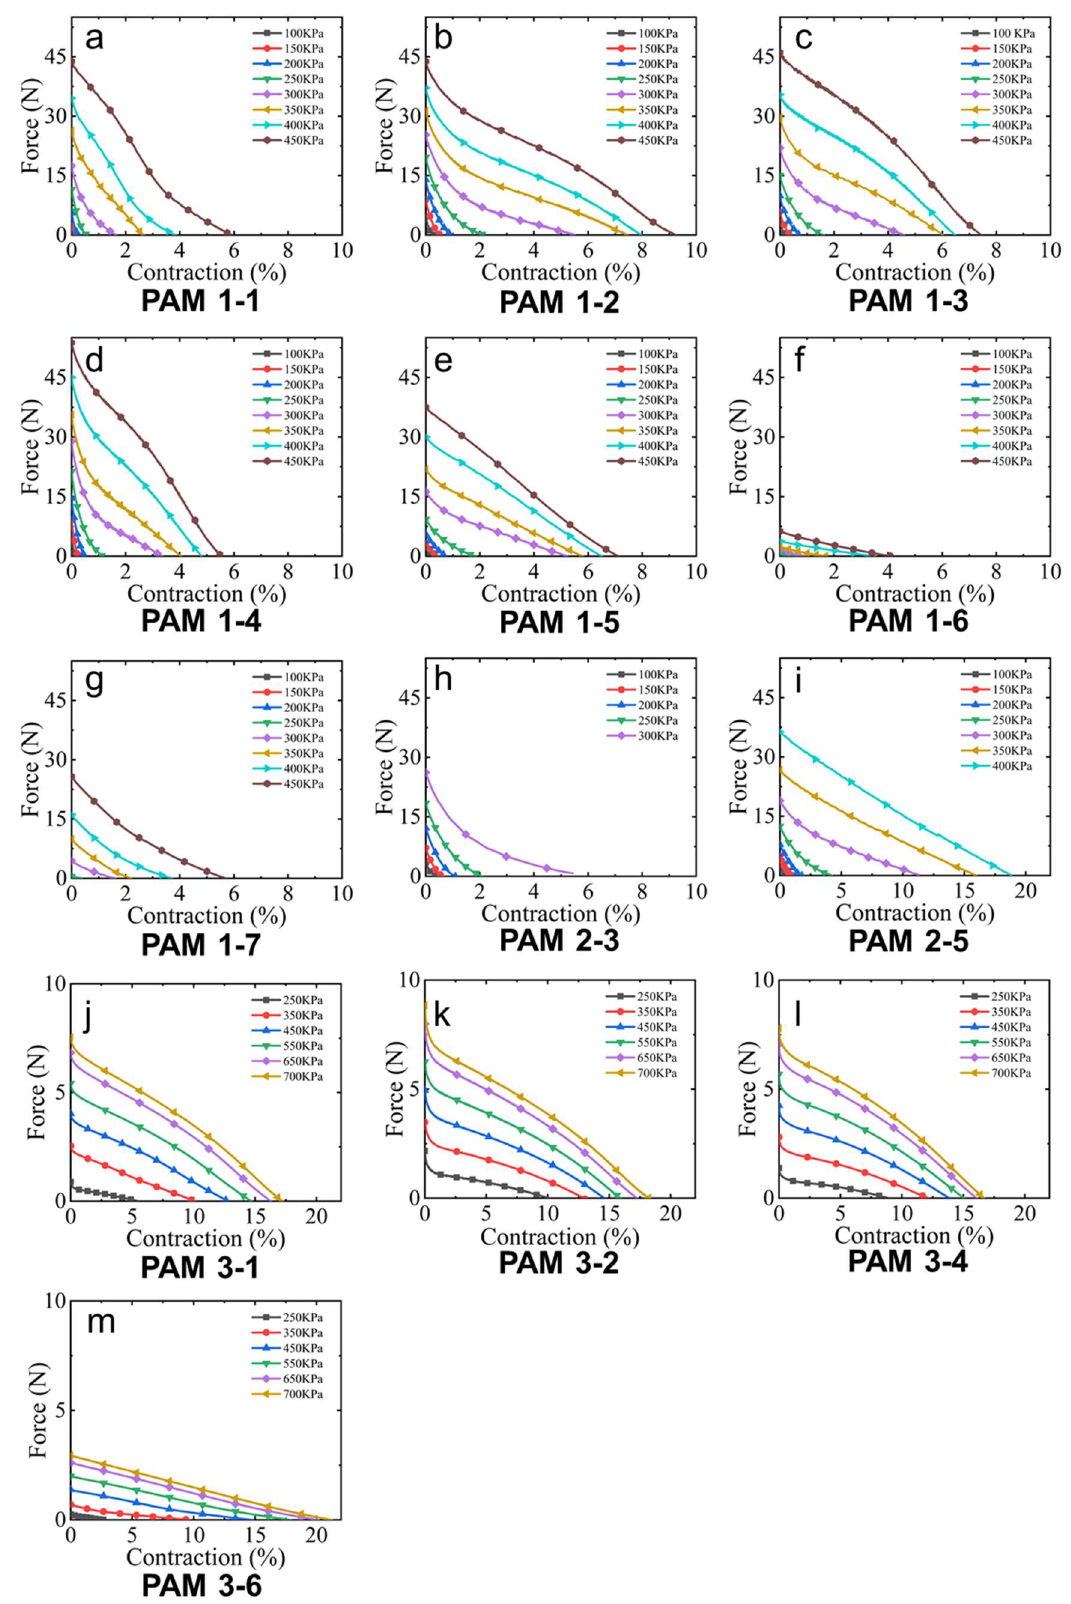
Figure 6. Force–contraction curves of different PAM samples at distinct pressure ranges: ( a ) PAM 1-1; ( b ) PAM 1-2; ( c ) PAM 1-3; ( d ) PAM 1-4; ( e ) PAM 1-5; ( f ) PAM 1-6; ( g ) PAM 1-7; ( h ) PAM 2-3; ( i ) PAM 2-5; ( j ) PAM 3-1; ( k ) PAM 3-2; ( l ) PAM 3-4; ( m ) PAM 3-6.